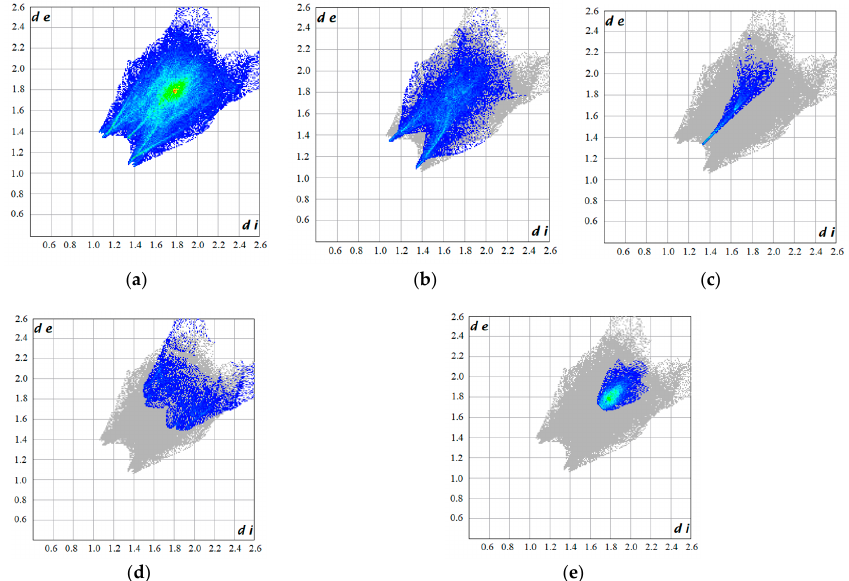
Figure 3. 2D fingerprint plots ( a ) and sections of the graph, which correspond to H ··· F ( b ), F ··· F ( c ), C ··· F ( d ) and C ··· C ( e ) interactions in structure 2 .